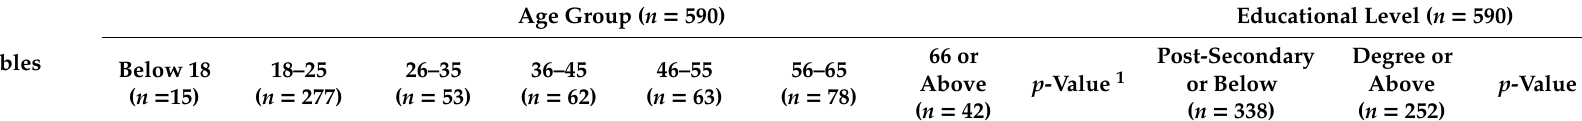
Table 4. Relationship of social health changes by demographic